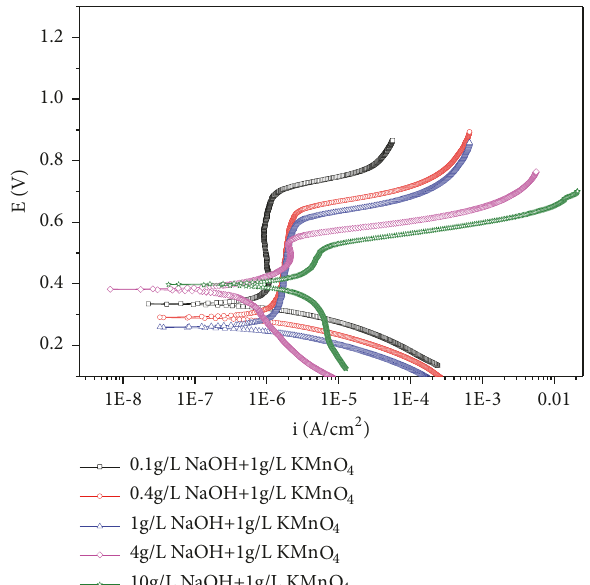
Figure 5: The potentiodynamic polarization curve of 304L SS in alkaline KMnO 4 solution.